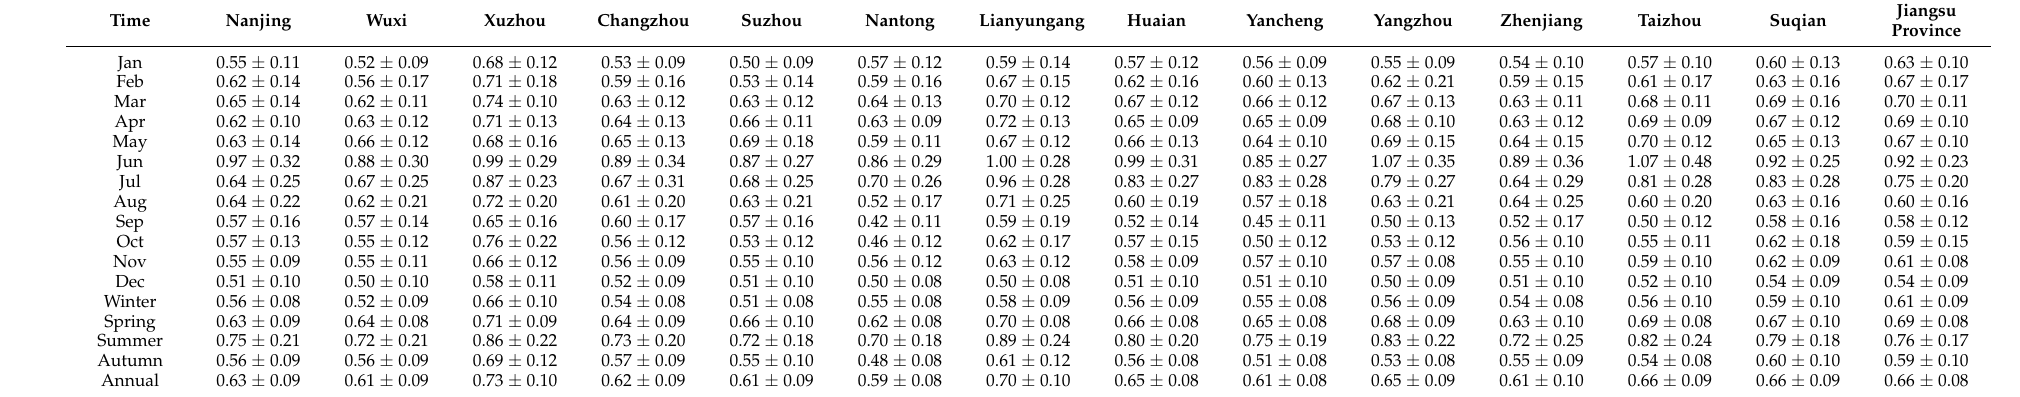
Table 2. City averaged monthly, seasonal and annual mean AOD ( ± STD) obtained from mean (Terra and Aqua) MODIS MAIAC algorithm from 2000 to 2020 in 13 cities in Jiangsu Province.